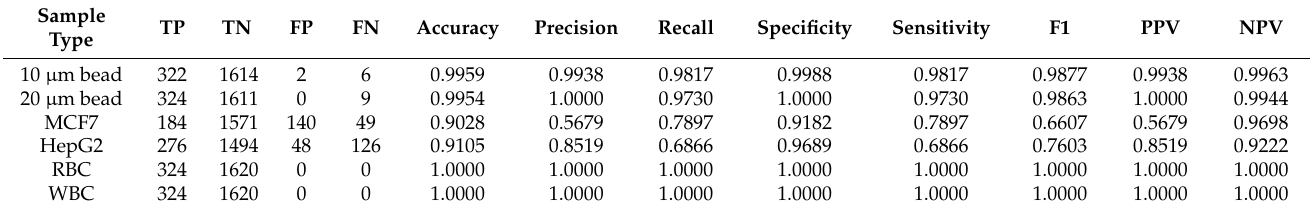
Table 2. Performance evaluation scores of the proposed AI model using various metrics for different cell